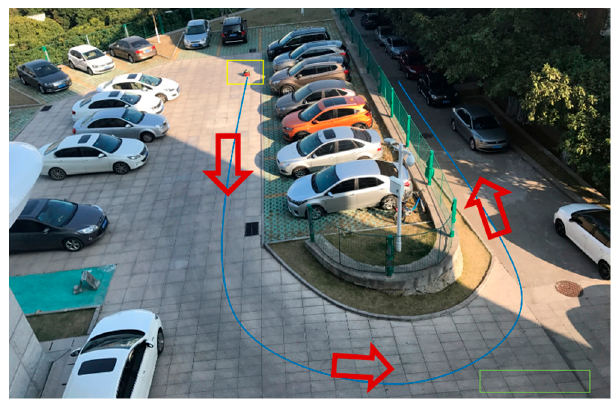
Figure 10. Scene3—a complex road with curve, downhill and slope.